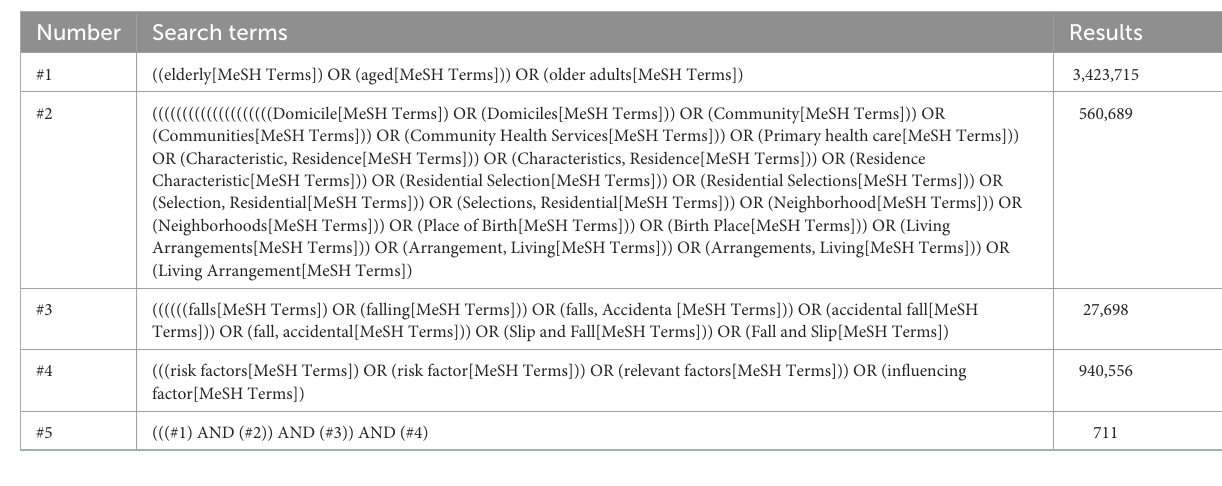
TABLE 1 Search strategy in PubMed